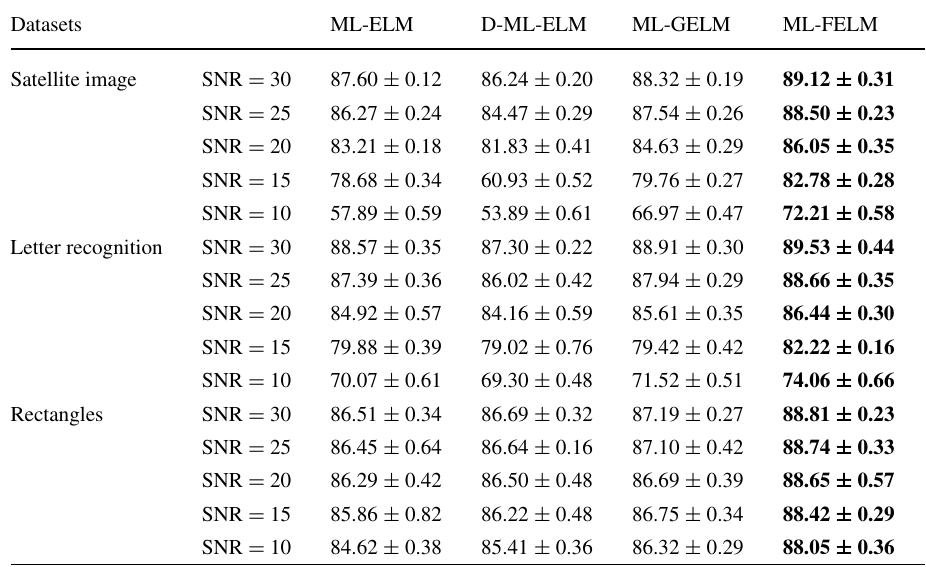
Table 7 The classification accuracy (%) of ML-ELM, D-ML-ELM, ML-GELM, and ML-FELM with different